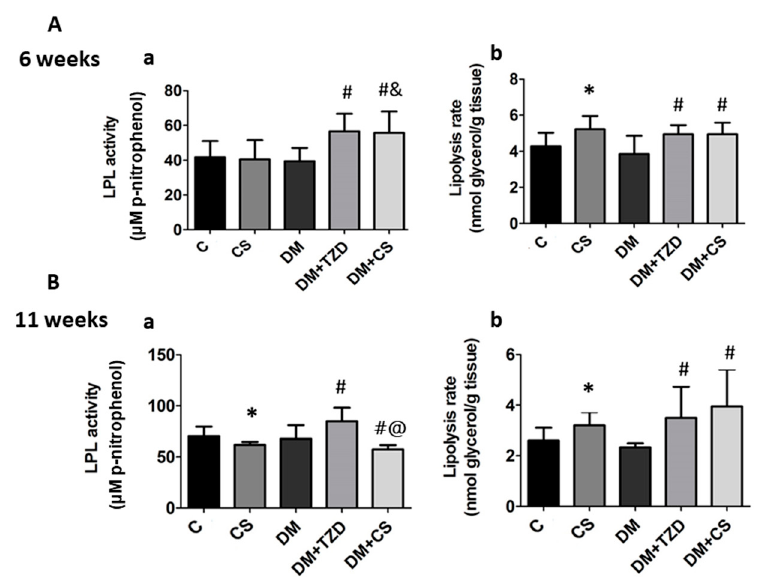
Figure 5. Effects of chitosan on LPL activity and lipolysis rate in the perirenal adipose tissue of diabetic rats with different feeding durations. ( A ) 6-week feeding duration; ( B ) 11-week feeding duration. ( a ) LPL activity; ( b ) lipolysis rate. Results are expressed as mean ± S.D. for each group (n = 8). Significant differences ( p < 0.05) analyzed by one-way ANOVA and two-tailed Student’s t -test. *: versus C; #: versus DM; &: versus CS; @: versus DM + TZD.